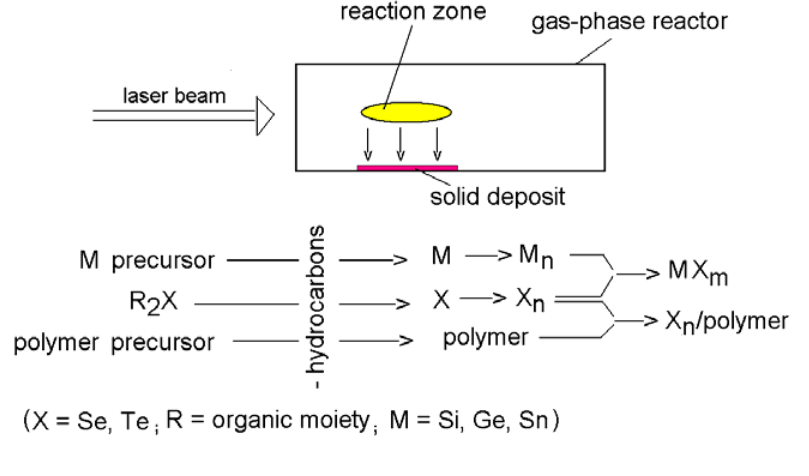
Figure 1. Scheme of decomposition, agglomerization and reaction/interaction between the decomposition